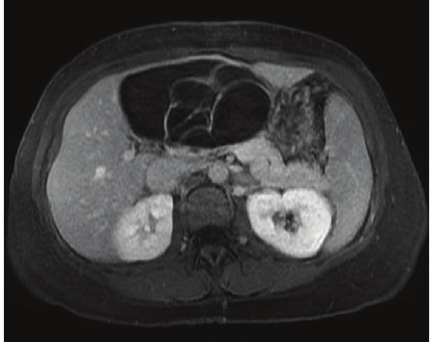
Figure 3: Name: axial LAVA PV following gadolinium administra- tion in the portal venous phase. Description: enhancement of the septations was observed following the administration of gadolinium on the axial T1 image with fat saturation.